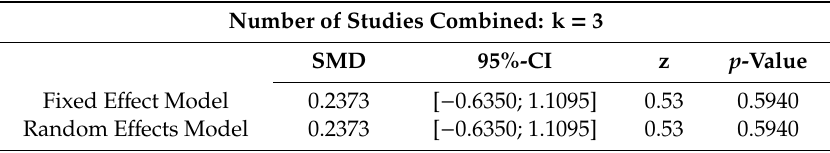
Table 14. A meta-analysis of specimen